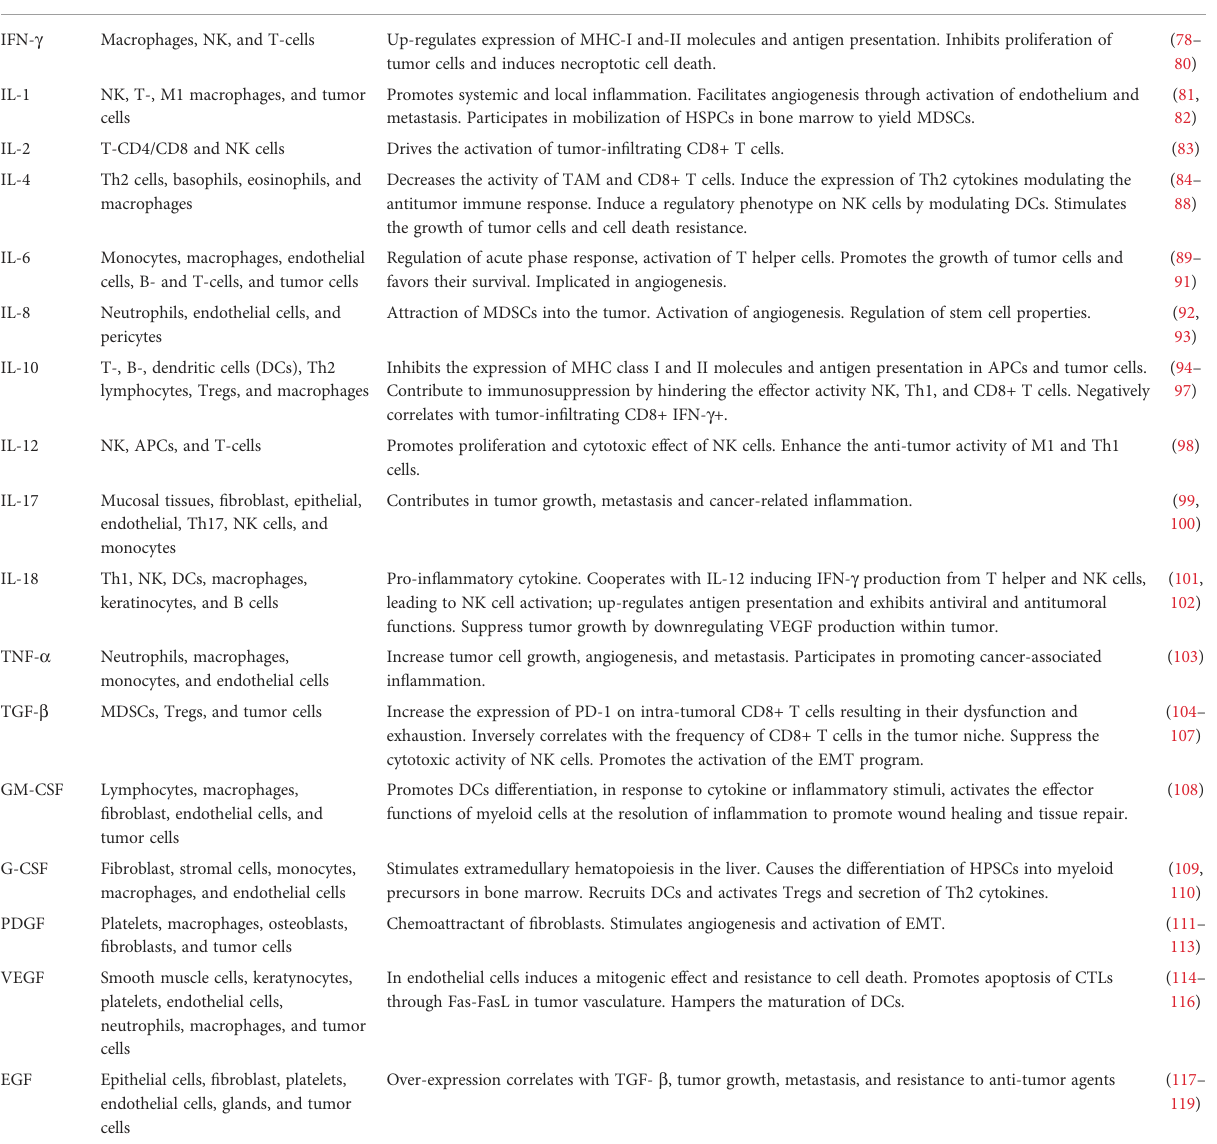
TABLE 1 Cytokines and Growth Factors associated with cancer-related in fl ammation. Cytokine Primary Target Cell Biological activity in cancer Ref. IFN- g Macrophages, NK, and T-cells